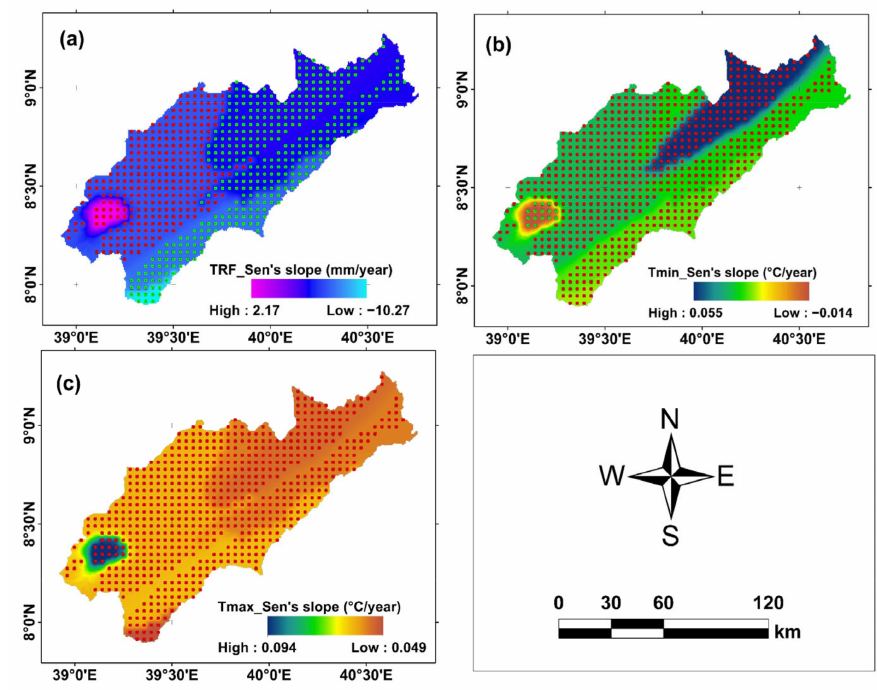
Figure 2. Trends of TRF ( a ), Tmin ( b ), and Tmax ( c ) of the study area. Red dots indicate 95% confidence level; green dots indicate not significant at 95% confidence